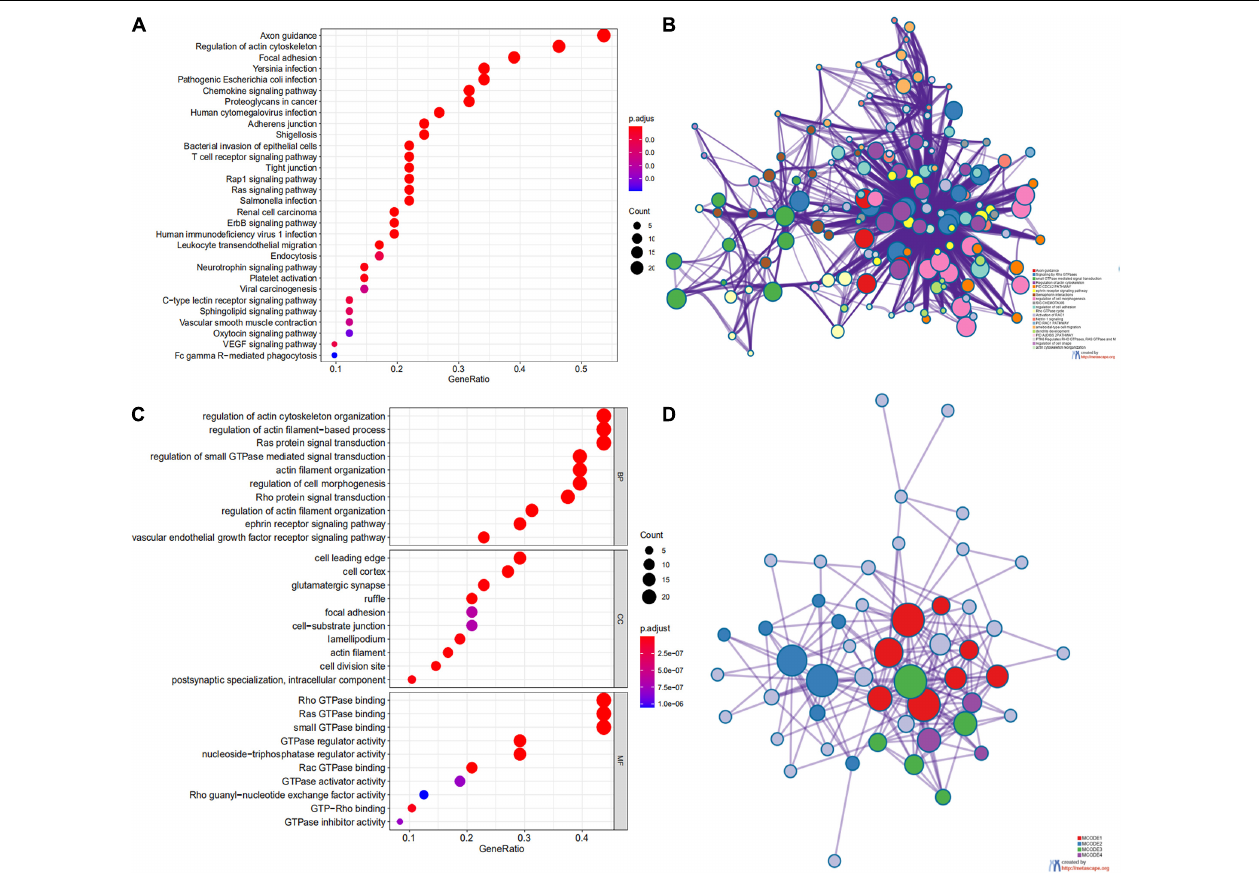
FIGURE 3 | Network and potent construction analysis of 50 ARHGAP family neighboring genes in BCa. (A) KEGG pathway analysis of 50 most neighboring correlated genes, p < 0.05. (B) GO analysis of 50 most neighboring correlated genes, p < 0.05. (C) Nodes contain differential genes, which are typically close to each other are displayed with the same color. Terms with a similarity > 0.3 are connected by edges. (D) Protein–protein interaction network and Molecular Complex Detection (MCODE) components identified of the hub correlating